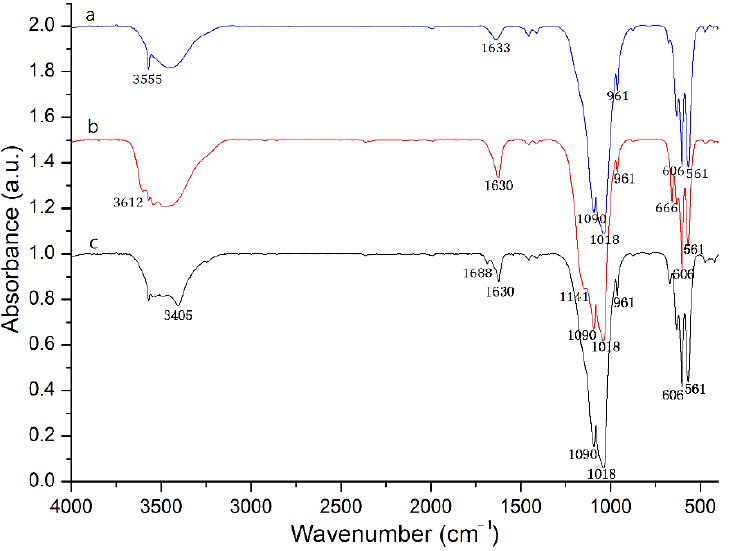
Figure 6. The FTIR results of the bone samples before and after the consolidation treatment. a. Untreated, b. treated by CSH suspension, c. treated by both the CSH suspension and water.